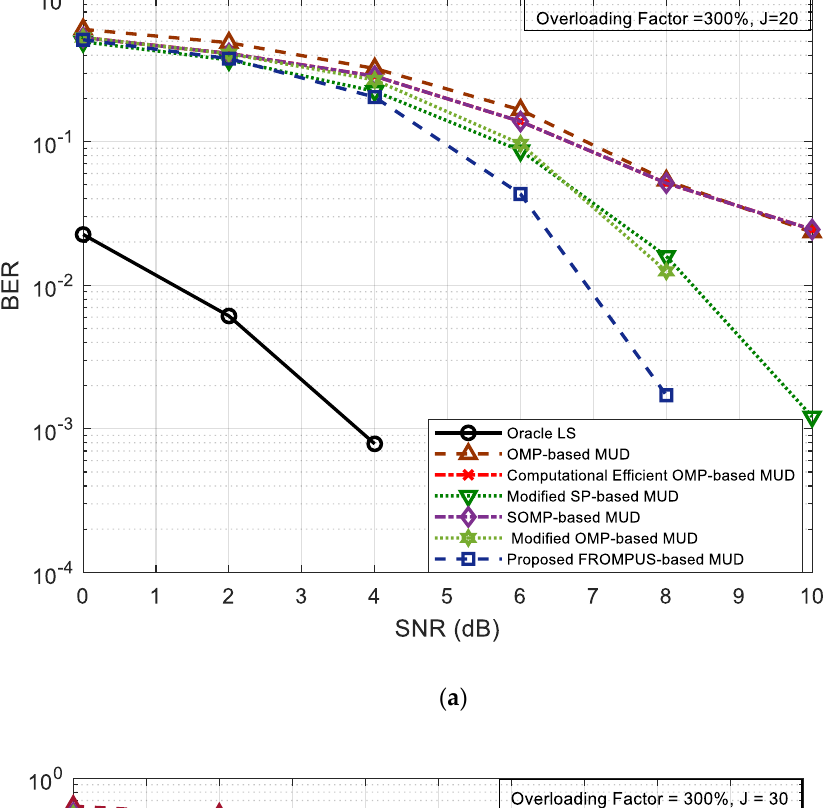
Figure 4. Achievable BER versus SNR performance of the FROMPUS-based MUD in comparison with five other MUDs, ℑ = 20 , and 𝑇 = 7 : ( a ) overloading factor= 150%; ( b ) overloading factor= 200%.